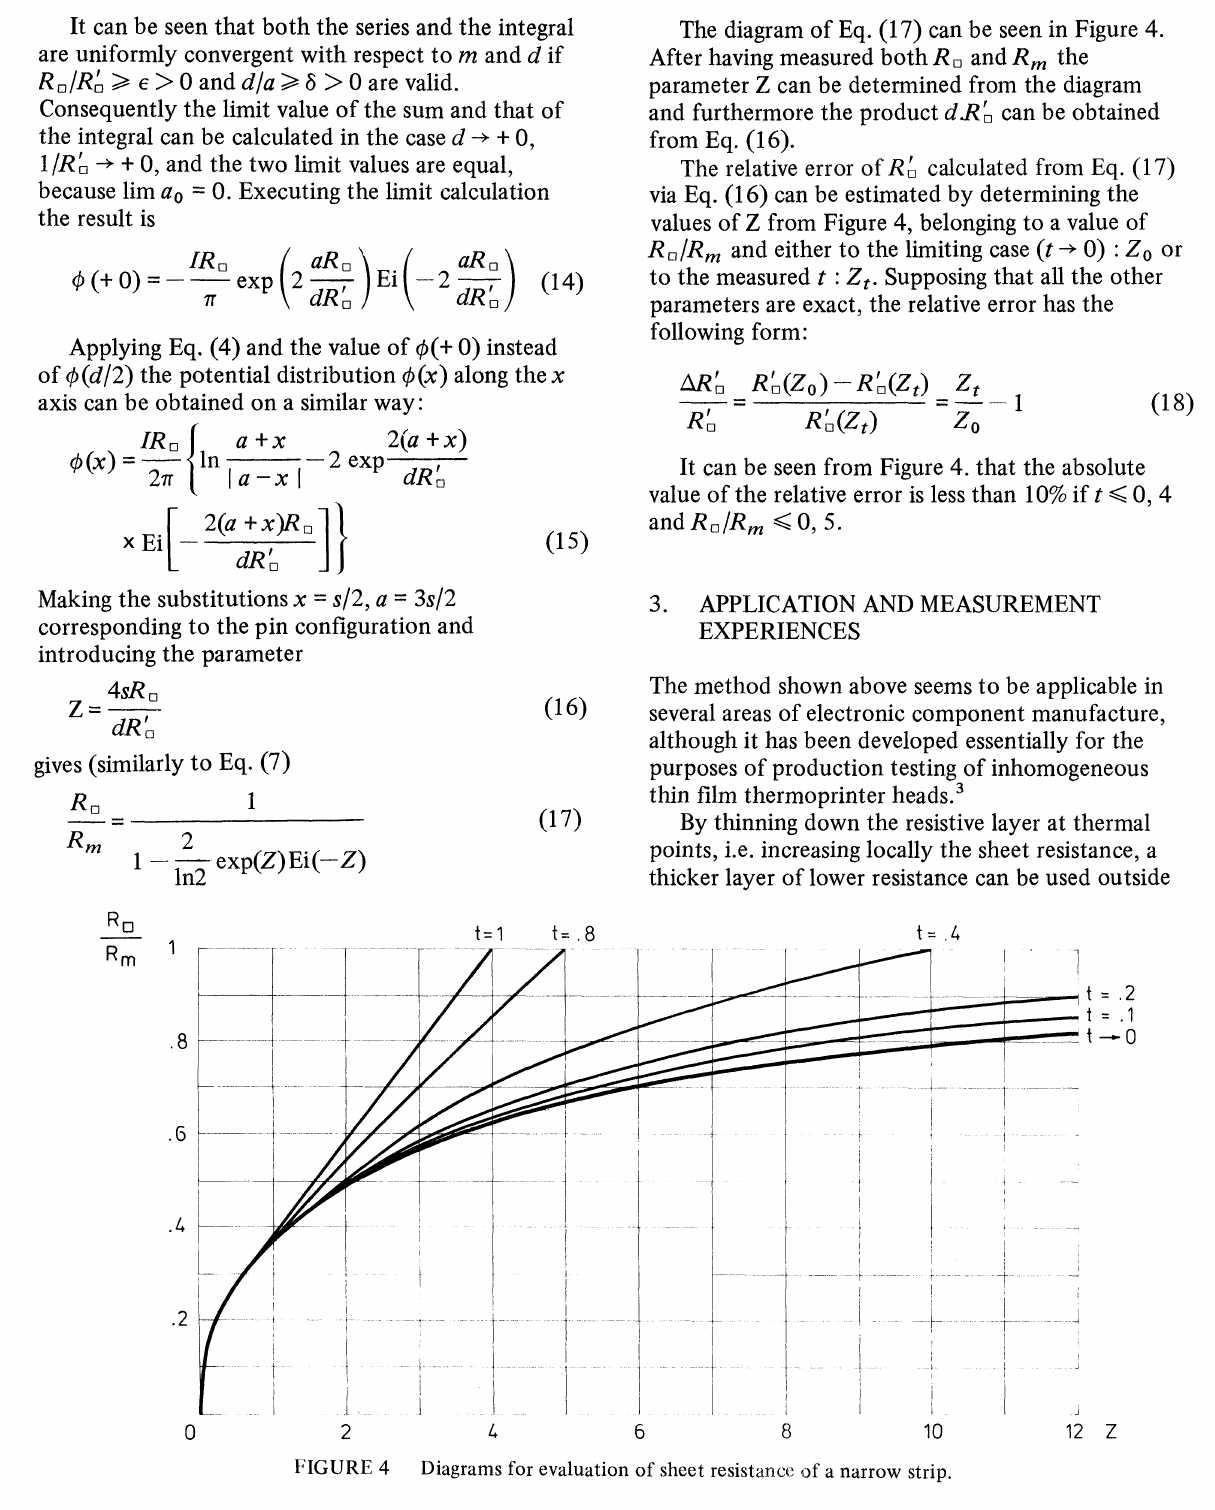
FIGURE 4 Diagrams for evaluation of sheet resistancc of a narrow